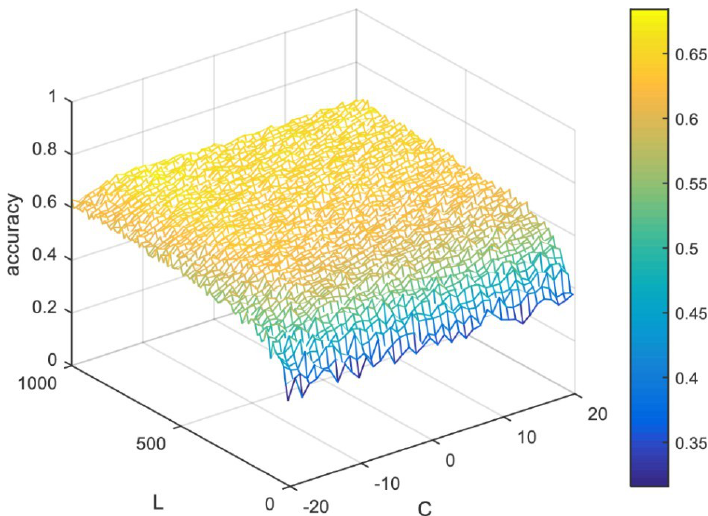
Figure 3. Mesh representation of the relationship between the accuracy, the number of neurons L, and the regularization parameter C for the extreme learning machine (ELM) classifier based on the UJIIndoorLoc dataset.